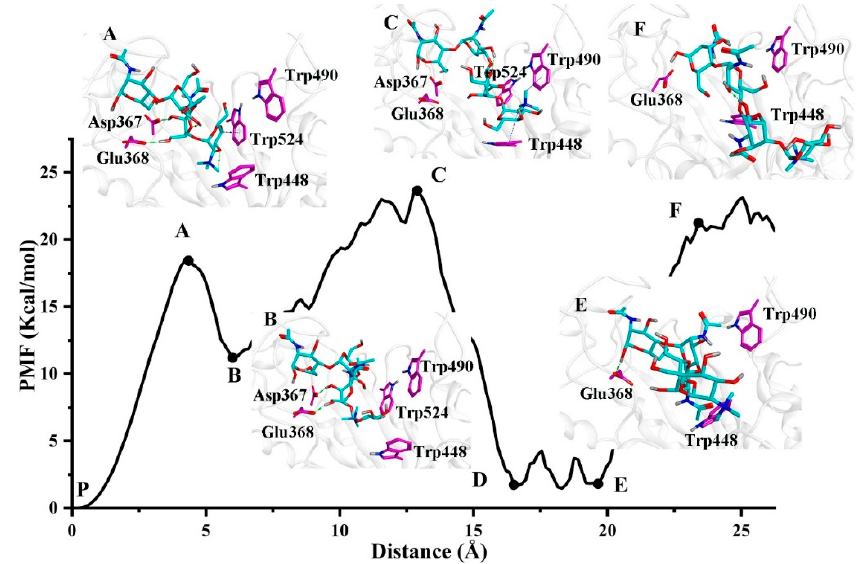
Figure 7. Structural characteristics of TMG-chitotriomycin O f Hex1 along the most possible unbinding route (Route 1).